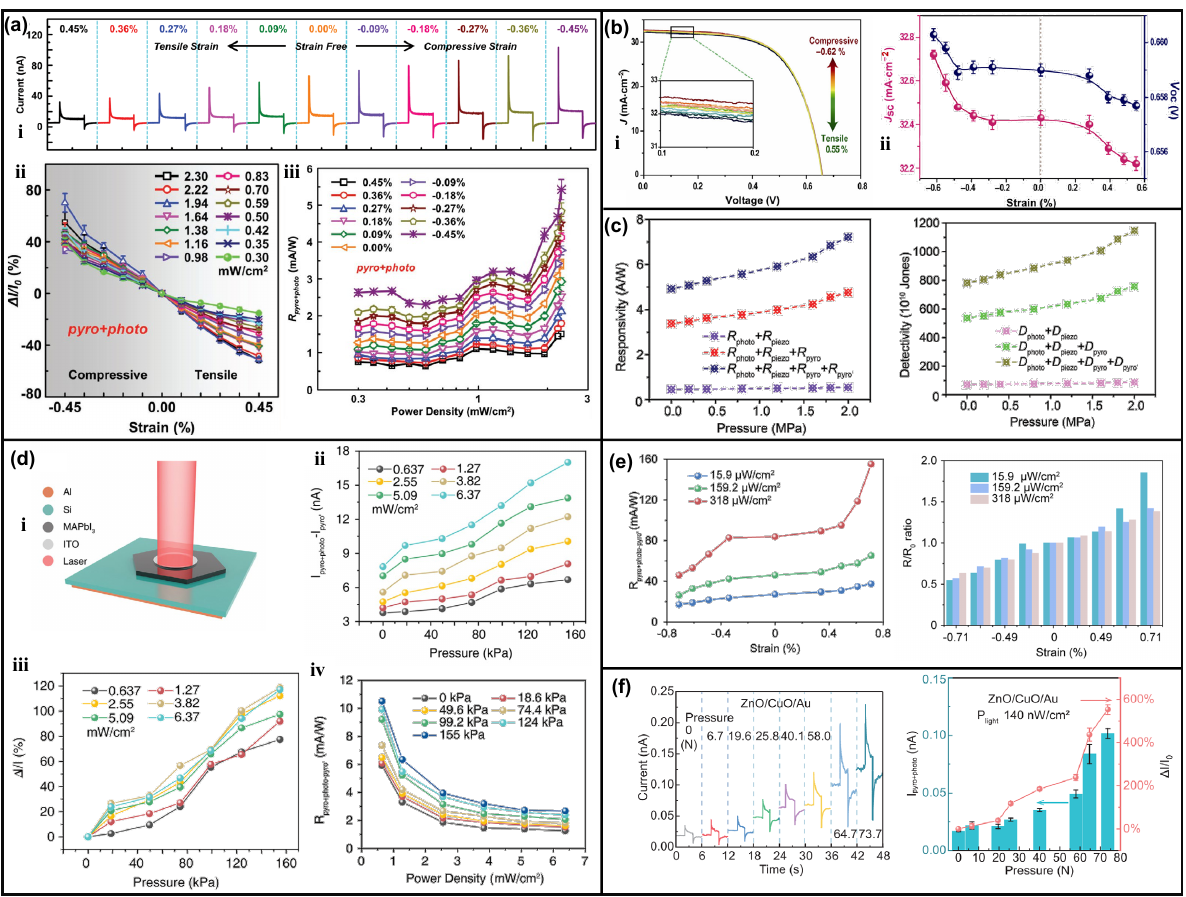
Figure 15. ( a ) The externally applied strain’s effects on the self-powered PEDOT:PSS/ZnO hetero- junction. ( ⅰ ) Transient I–t characteristics of the pyro-phototronic-effect-enhanced photodetector under 325 nm 2.30 mW/cm 2 UV illumination with different strains; ( ⅱ ) The relative change of I pyro + photo , ΔI/I 0 , as a function of externally applied strain under different power densities; ( ⅲ ) The calculated